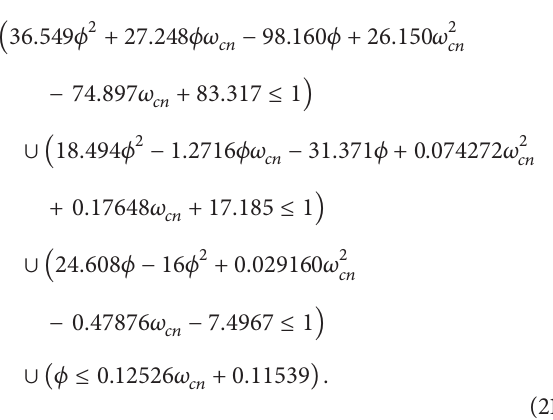
Figure 3: Frequency specifications region for 𝐼 𝛼 controller.